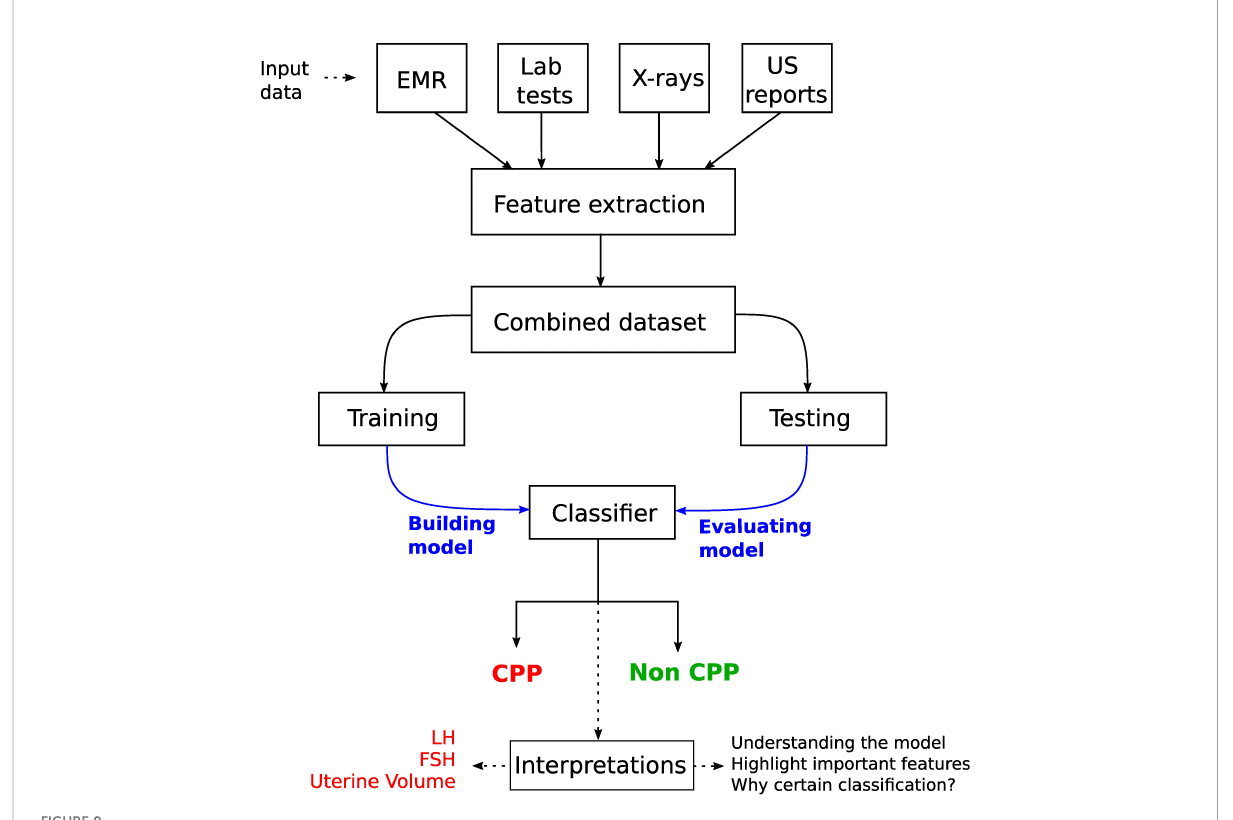
FIGURE 9 Work fl ow for a CPP diagnostic system by considering multiple sources of information in young girls. A key step is the interpretation of the model prediction, which highlighted the usefulness of LH and FSH levels (from laboratory tests) and uterine volume (obtained from pelvic